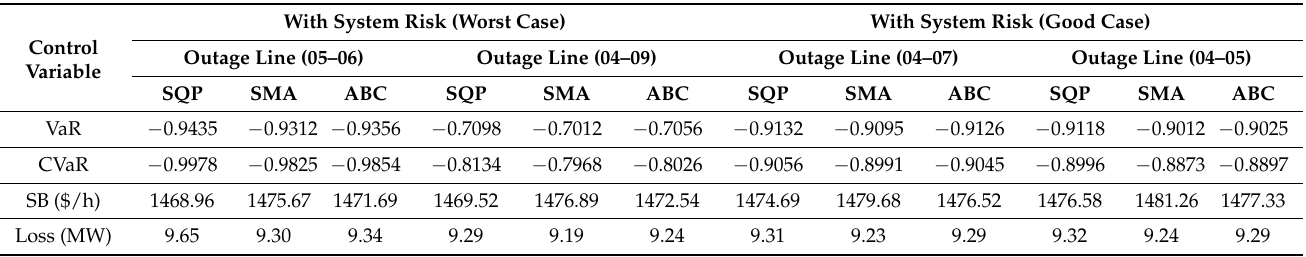
Table 3. Social benefit and loss values with considering system risk under deregulated environment for IEEE 14-bus